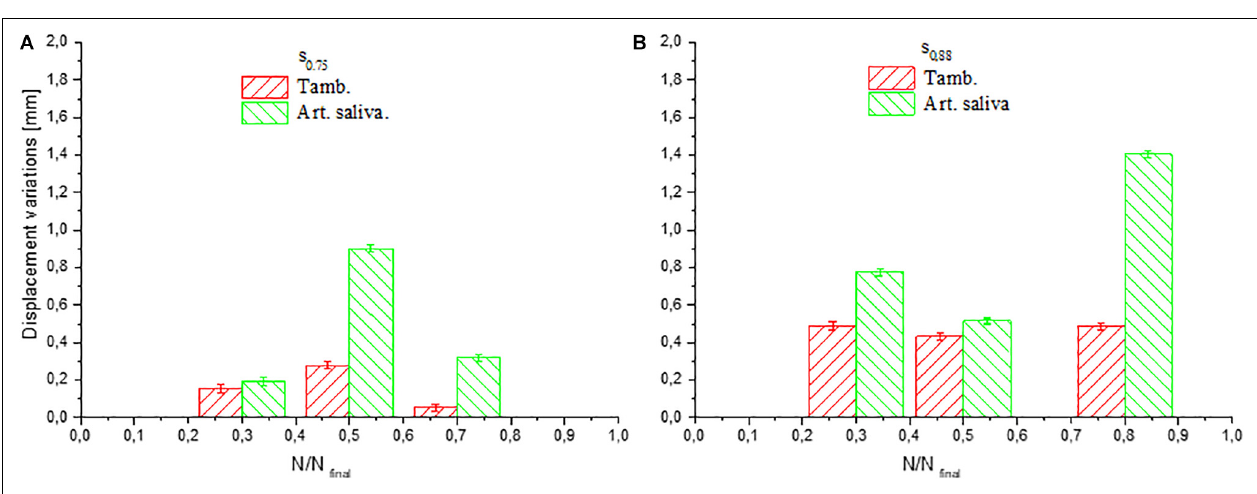
FIGURE 8 | Displacement variation among the different days for the two PET_G copolymer thickness: (A) sample of 0.75 mm thick tested in both atmospheric environment ( ∼ 25 ◦ C) and in presence of artificial saliva and (B) sample of 0.88 mm thick tested in both atmospheric environment ( ∼ 25 ◦ C) and in presence of artificial saliva. ( N / N final = fraction of compression test